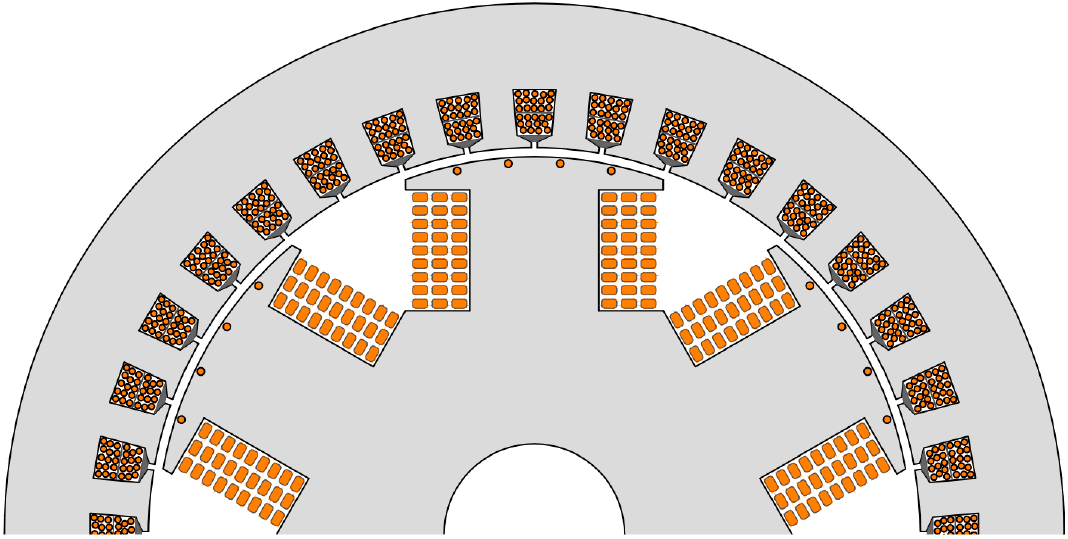
Figure 1. Cross-section representing the topology of the synchronous generator to be designed. The design procedure allows either single-layer or double-layer armature winding. Although the design equations regard the bottom of the slot as straight-shaped (trape- zoidal slots), a rounded bottom (dashed lines in Figure 2) could be easily implemented by changing (24) to calculate the correct slot surface that would be slightly